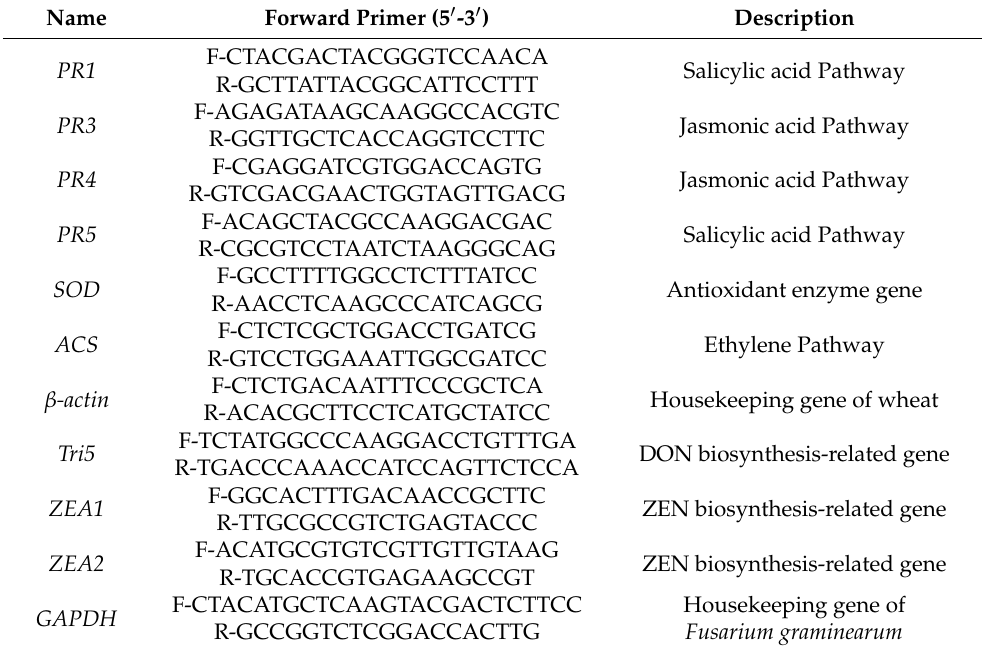
Table 1. Primers for